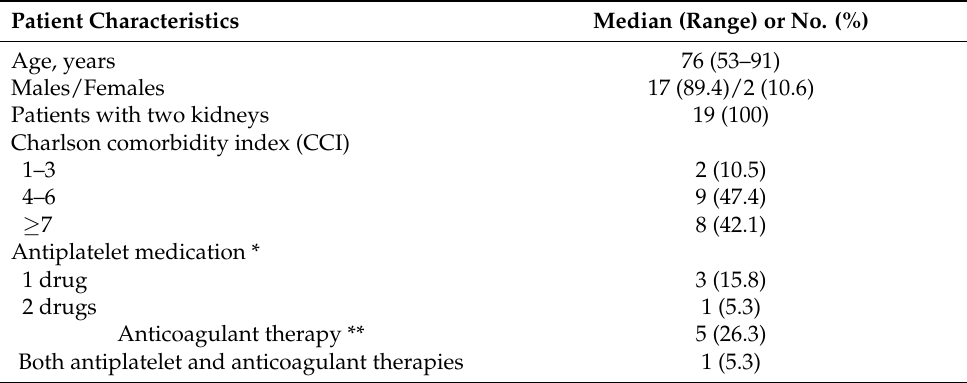
Table 1. Characteristics of the 19 patients included in the study.